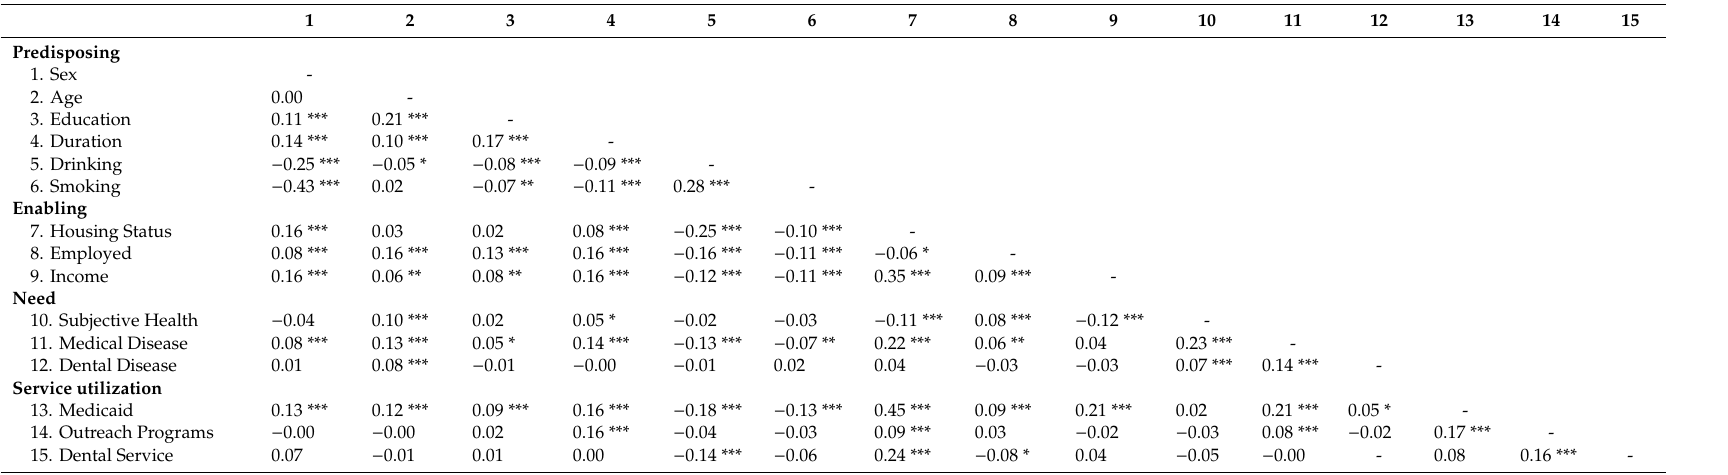
Table 3. Correlations among variables in homeless people, Seoul.